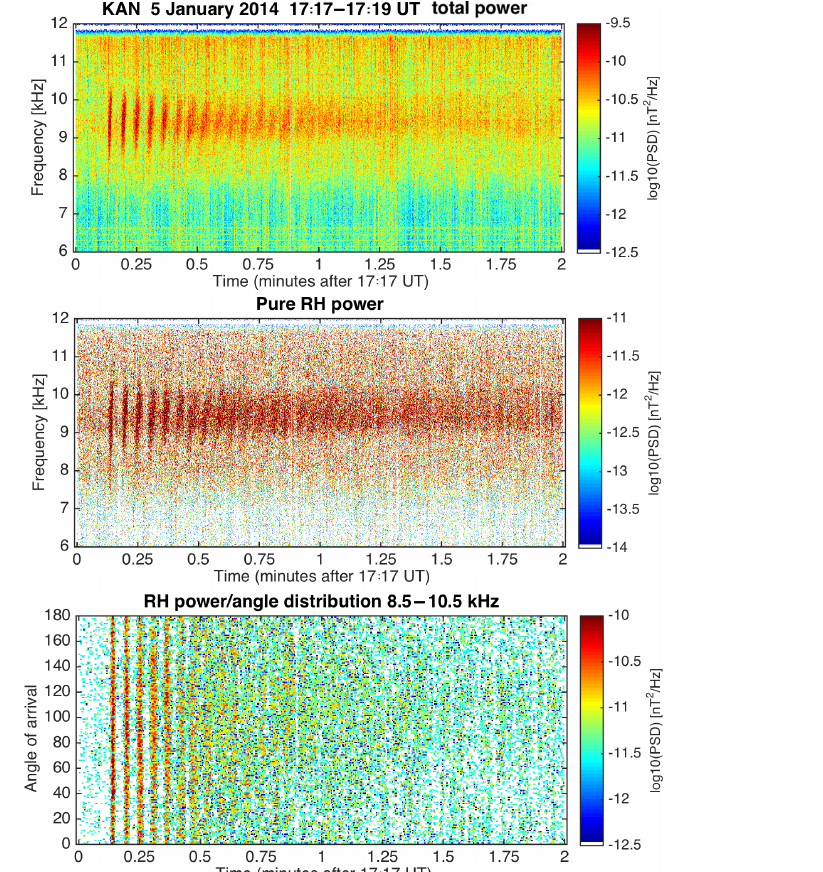
Figure 5. The 6–12kHz VLF spectrograms (total and right-handed powers) of 2min duration and the wave power/angle distribution based on pure right-hand power at 8.5–10.5kHz of the short-period QP emissions on 5 January